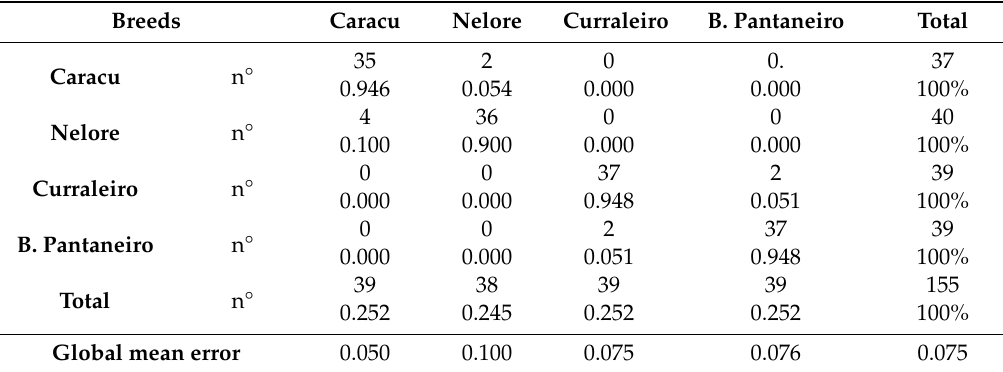
Table 6. Discriminant analysis, number of observations, and percentage of classification obtained from the microstructural characteristics of guard hairs of 155 bovine breeds Caracu, Curraleiro P é -Duro, Pantaneiro and Nelore (trichological